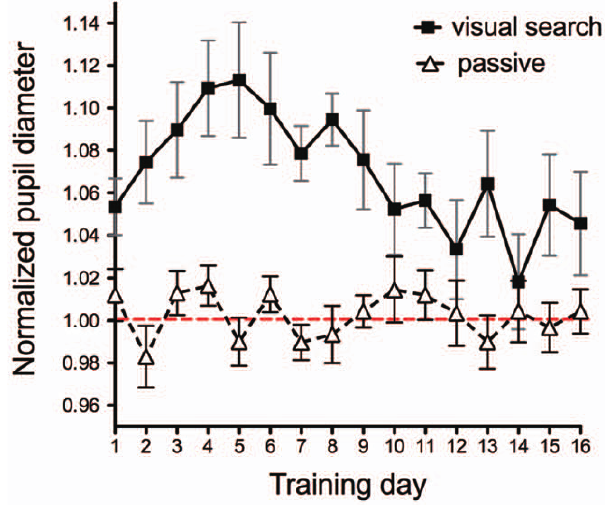
Figure 4. Normalized average pupil diameter as a function of the training day. Filled squares denote the averaged pupil diameter of 12 subjects conducting the visual conjunction search task. In the passive condition (blank triangles), subjects observed the same display but no task was imposed. The data was calculated from Fig. 3. Error bars represent 6 1SEM.